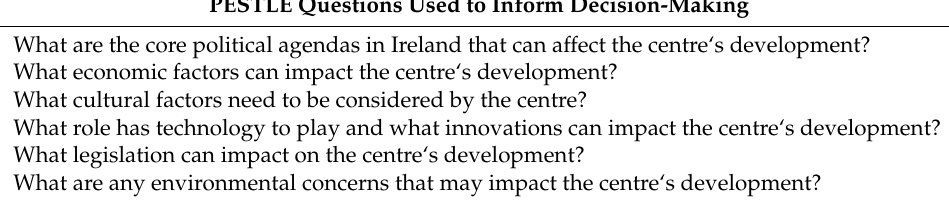
Table 2. PESTLE Questions Used to Inform Decision-Making [28]. PESTLE Questions Used to Inform